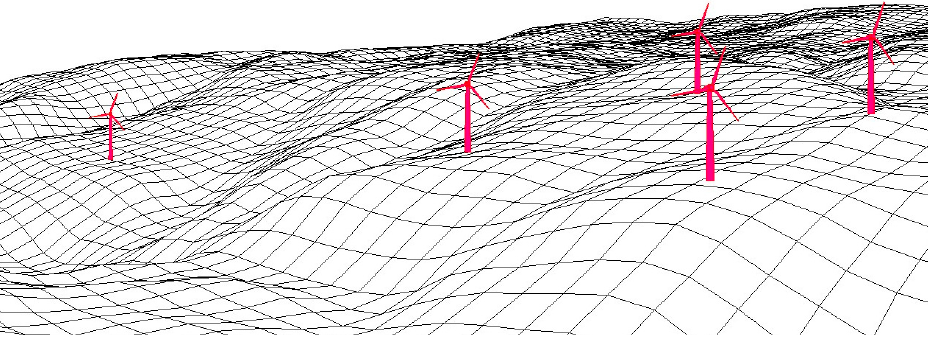
Figure 10. Location of viewpoints of interest in the surrounding wind farms (WFs) from the SSW.